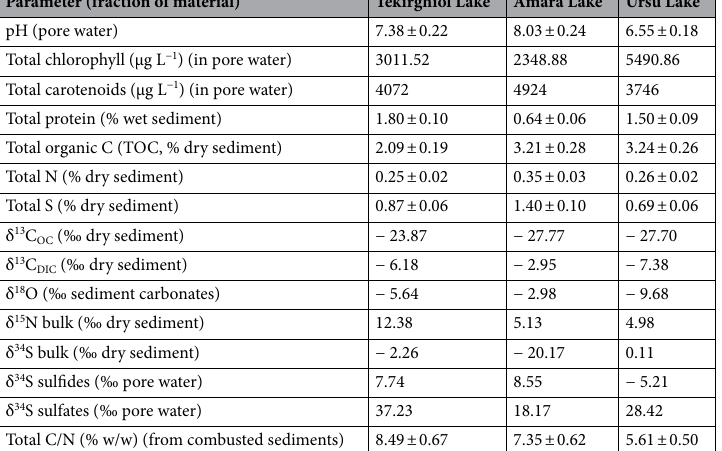
Parameter (fraction of